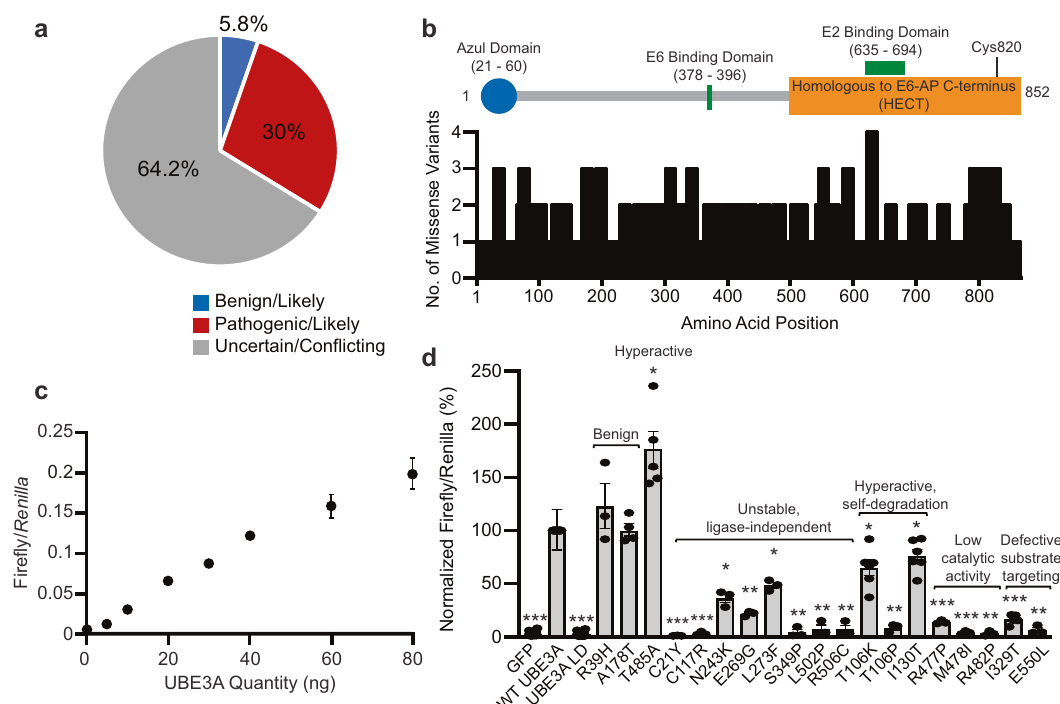
Fig. 1 Genetic variation in UBE3A. a The distribution of clinical interpretations in ClinVar for missense variants identi fi ed in UBE3A. Blue: Benign/Likely Benign, Red: Pathogenic/Likely Pathogenic, Gray: Uncertain/Con fl icting. b Schematic showing human UBE3A with known functional domains. The number of variants and their positions corresponding to the UBE3A protein sequence are shown. c Cultured cells were transfected with increasing amounts of plasmid encoding WT UBE3A. Mean values are shown for Fire fl y/ Renilla ratios ± standard error (SE). N = 3 independent experiments. d BAR responses of variants were normalized to WT UBE3A responses in each experiment. Values are shown as the mean ± SE. Each variant was tested in triplicate per experiment and the resulting values averaged. The number of experiments performed ( n ) and p -values calculated using a one-sample t -test (two-tailed) with Benjamini – Hochberg multiple comparisons correction (FDR = 0.05) are as follows: GFP, n = 19, *** p = 1.733 × 10 − 31 ; WT UBE3A, n = 19; UBE3A